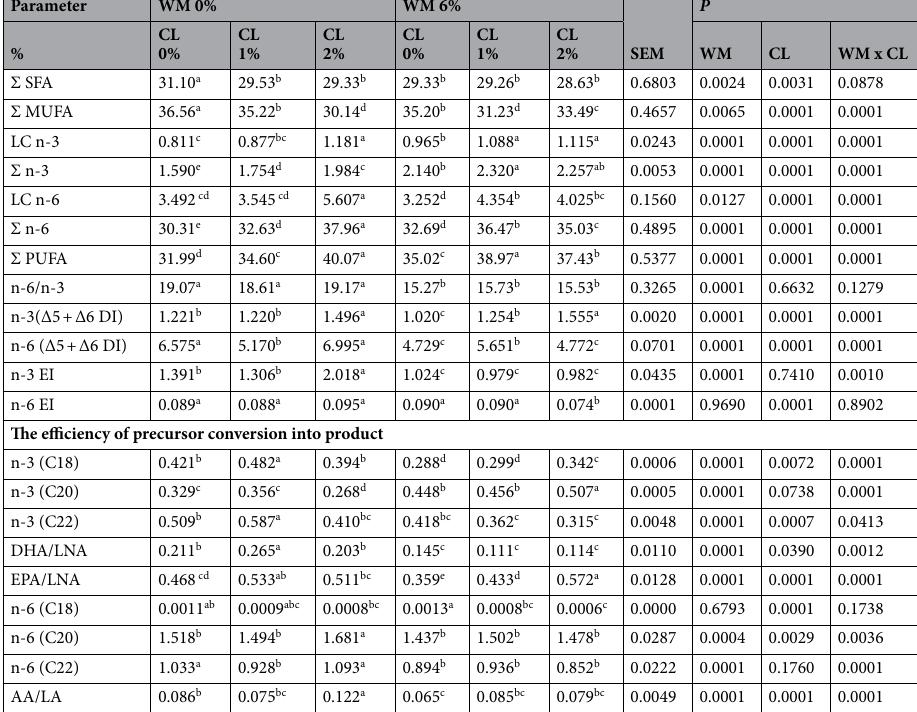
Table 2. Effect of WM and CL on lipid quality indices based on fatty acids profile of breast meat. Means within a row with no common superscript differ ( p < 0.05). SFA Saturated fatty acids, MUFA Monounsaturated fatty acids, PUFA Polyunsaturated fatty acids, LC n-3 Long-chain n-3 fatty acids, LC n-6 Long-chain n-6 fatty acids, n3(Δ5 + Δ6 DI) or n6(Δ5 + Δ6 DI) Desaturase index Δ5 + Δ6 for n-3 or n-6 fatty acids, n-3 EI or n-6 EI Elongase index for n-3 or n-6 fatty acids, LNA (C18:3n-3); EPA (C20:5n-3); DHA (C22:6n-3); LA (C18:2n-6); AA